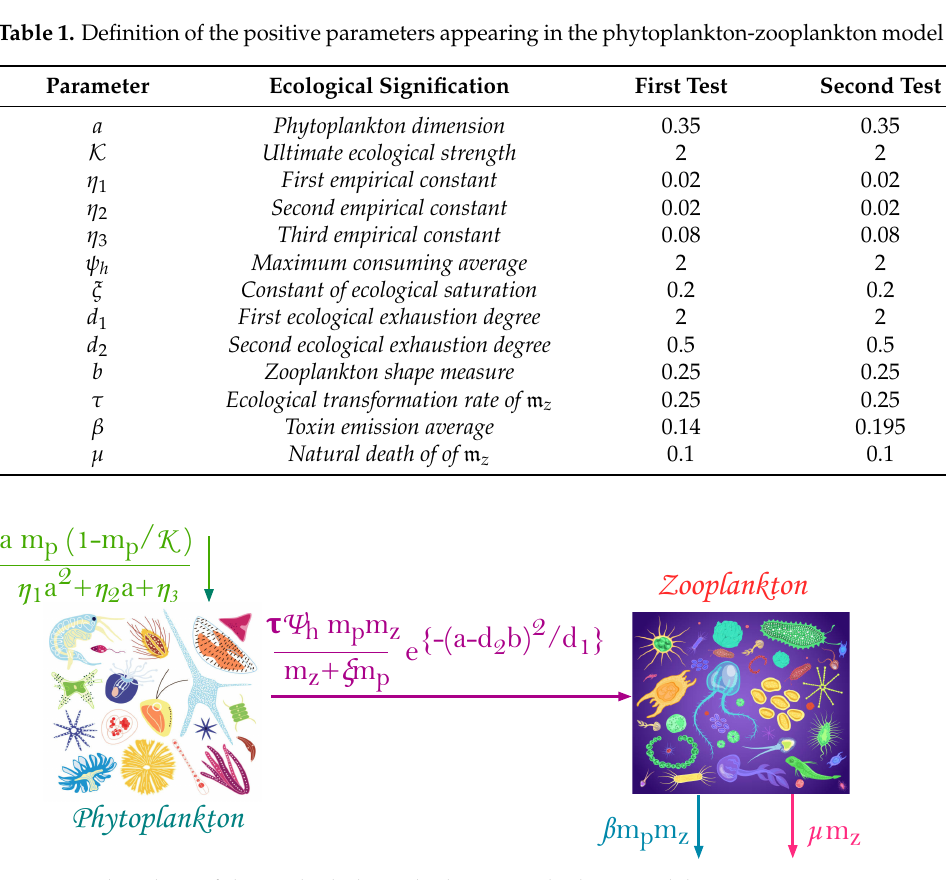
Figure 2. Flowchart of the studied phytoplankton-zooplankton